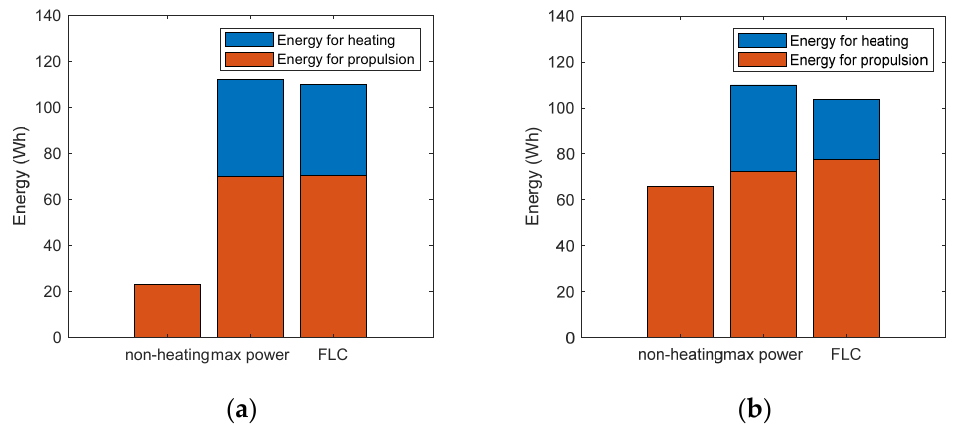
Figure 13. External heating tests at constant load power. ( a ) Initial cell temperature of − 30 °C, initial SOE of 30%, and cell discharging power of 50 W; ( b ) initial cell temperature of − 10 °C, initial SOE of 50%, and cell discharging power of 30 W.